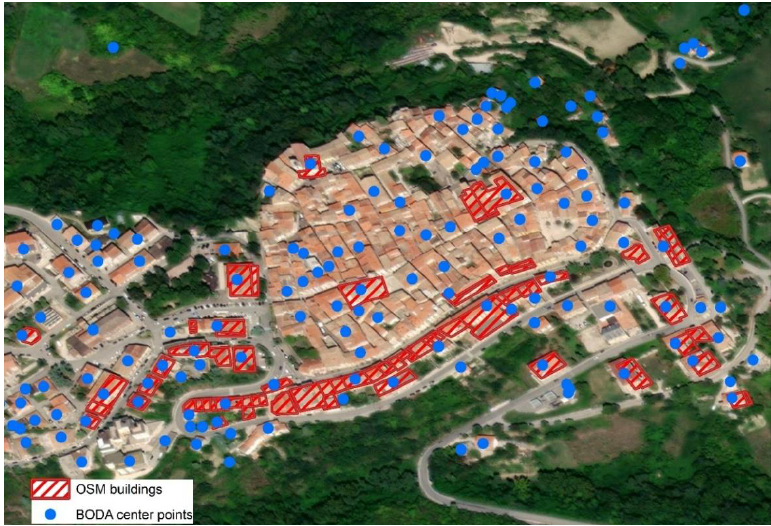
Figure 4. An example of BODA building centroid overlay on OSM building database for the munic- ipality of Frosolone, Molise (Southern Italy). Apulia and Veneto regions ranked in the first positions together with Liguria (93.2%) and Friuli–Venezia–Giulia (88.2%). These results also document the regional heterogene- ity in the building representation typical of OSM and BODA databases (Table 4). Table 4. ( Left ) Percent share of BODA buildings found in the OSM archive in total BODA coverage; ( right ) percent share of OSM building area that overlaps with BODA building area in Italy in total OSM building area, by administrative region and urban/rural district. Region